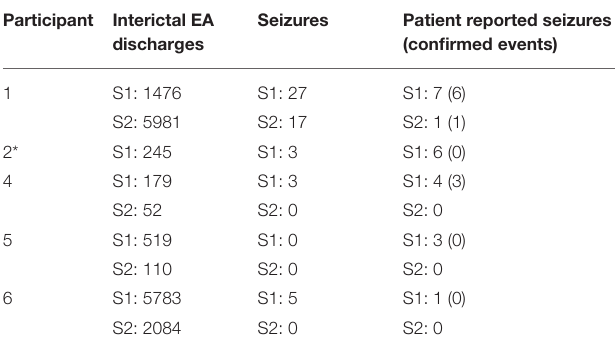
TABLE 2 | Clinically relevant EEG events during the two 7-day EEG